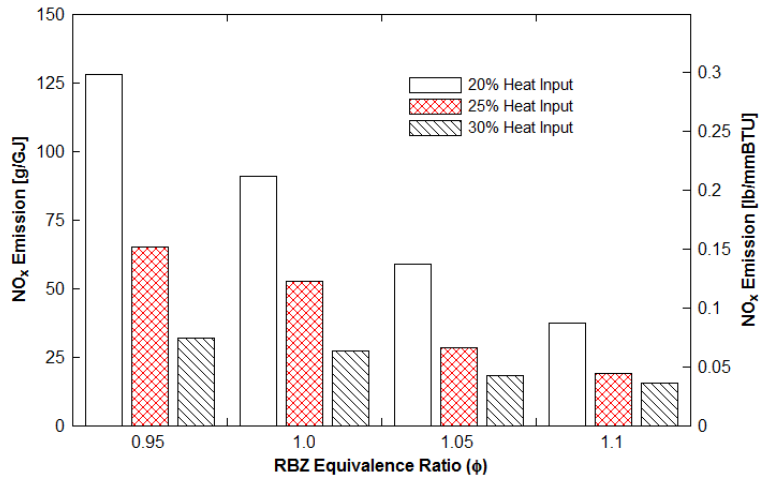
Figure 11. Effect of the reburn heat input using LASSDB (non-vitiation and 0° reburn